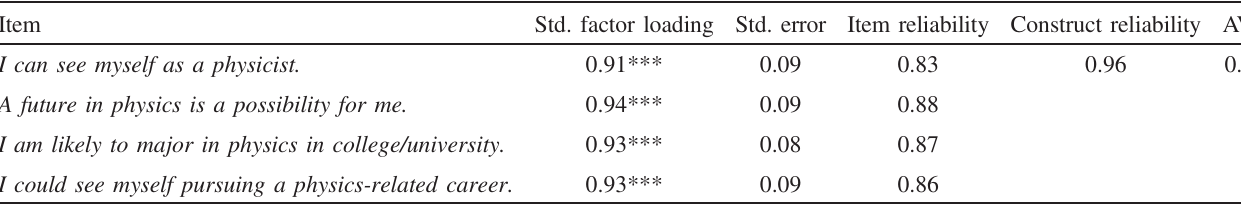
TABLE I. CFA results for Study 1. Item